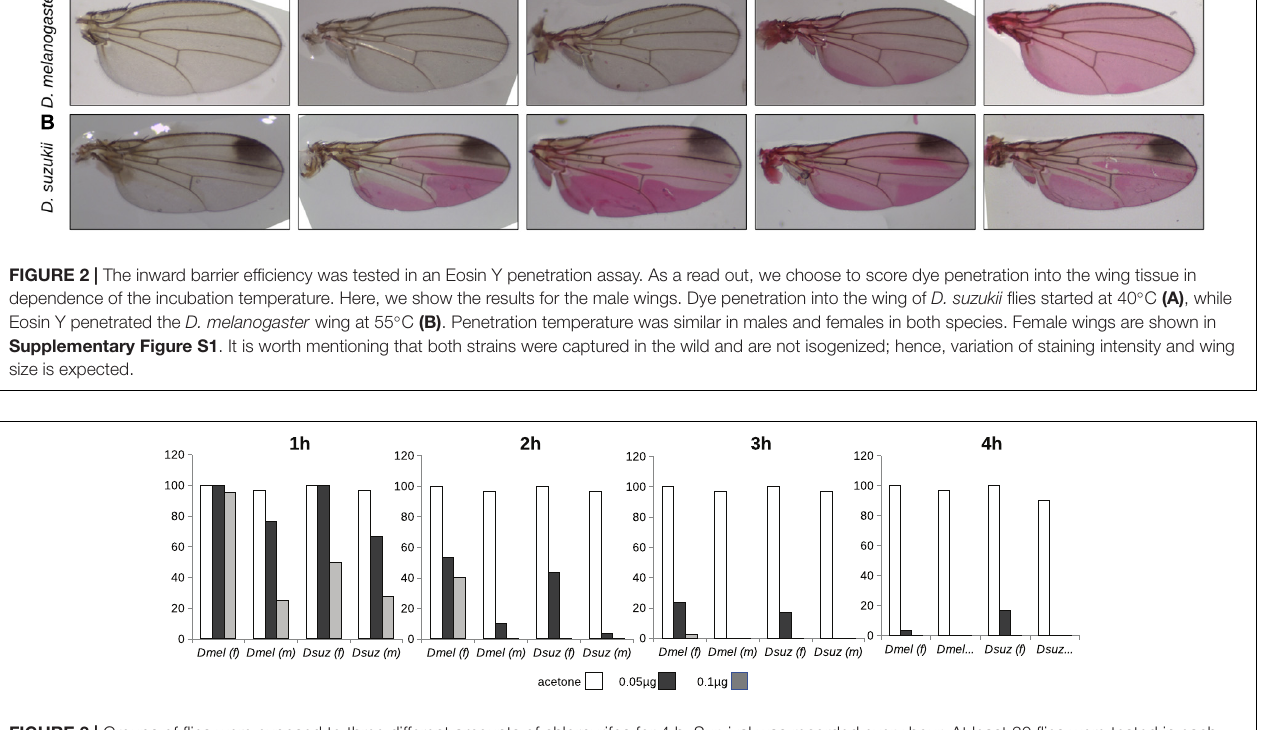
in D. melanogaster and D. suzukii males and females. While fas3 expression was higher in D. suzukii males than in D. melanogaster males, it did not differ between D. melanogaster and D.